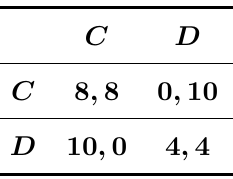
Table 4. A prisoner’s dilemma